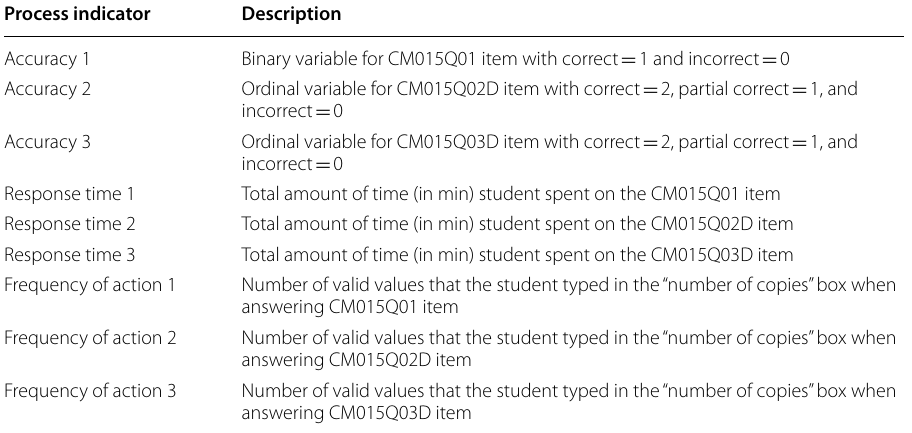
(1) The computation of the response time is the difference on the amount of time for the “START” and “END” trace log events. (2) Example of possible valid values in the “number of copies” box are: 1; 20; 500; or 1000